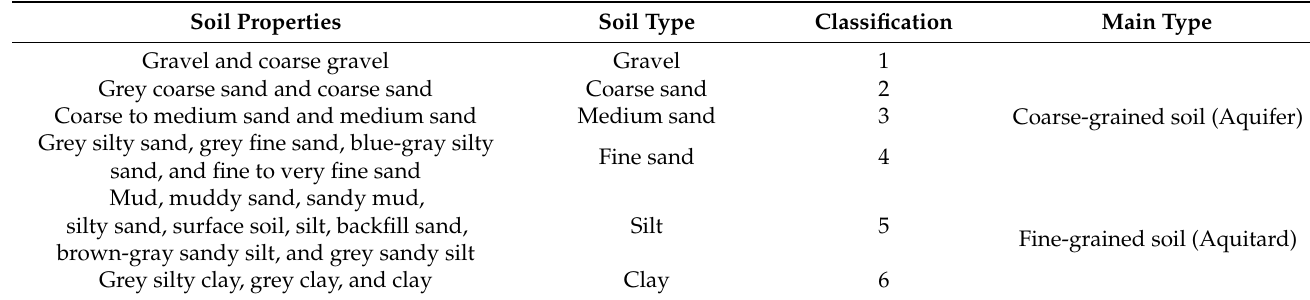
Table 2. Soil classification from the Water Resources Agency [26].